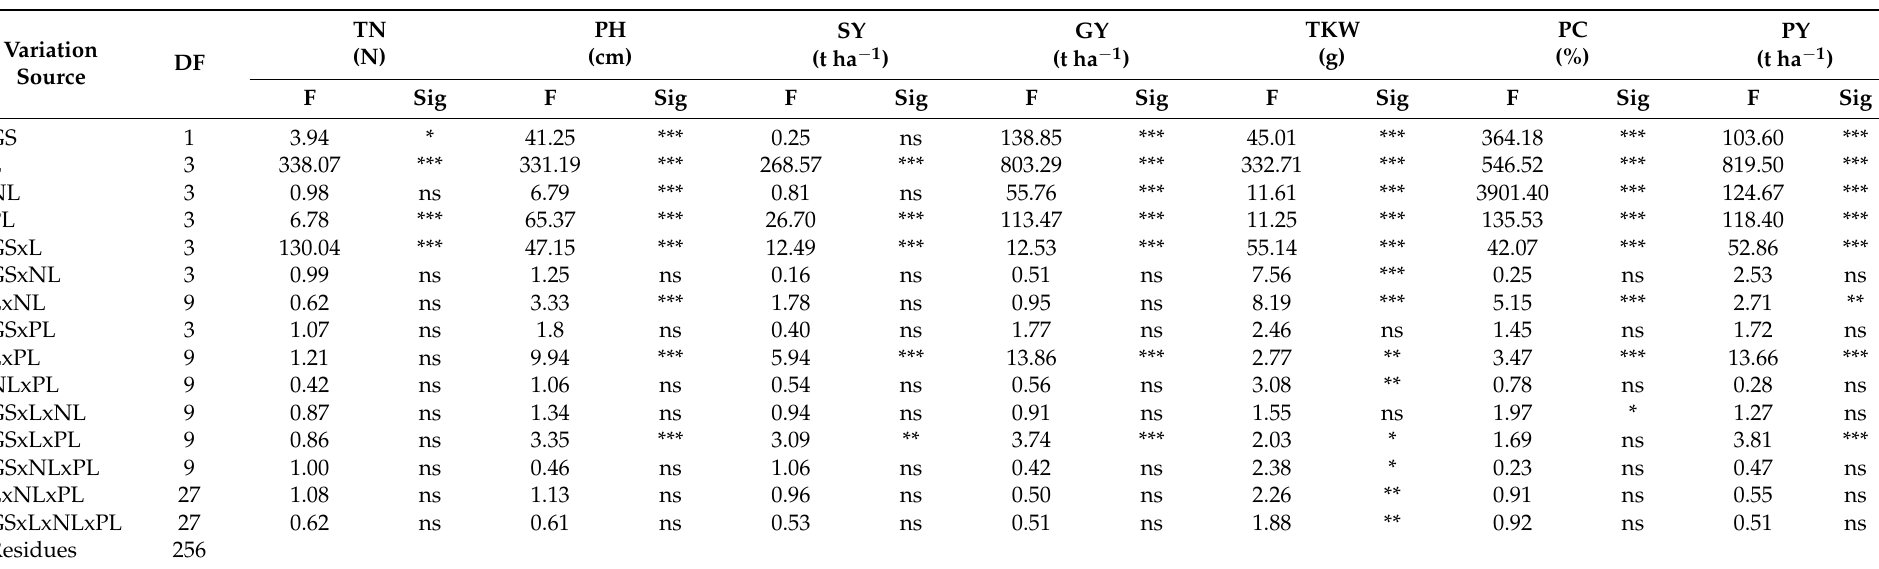
Table 2. The results of the ANOVA on tiller number (TN), plant height (PH), grain yield (GY), straw yield (SY), 1000 kernel weight (TKW), protein concentration (PC), and protein yield (PY), by factors including growing season (GS), location (L), nitrogen (NL), and phosphorus (PL) fertilization treatment. The table